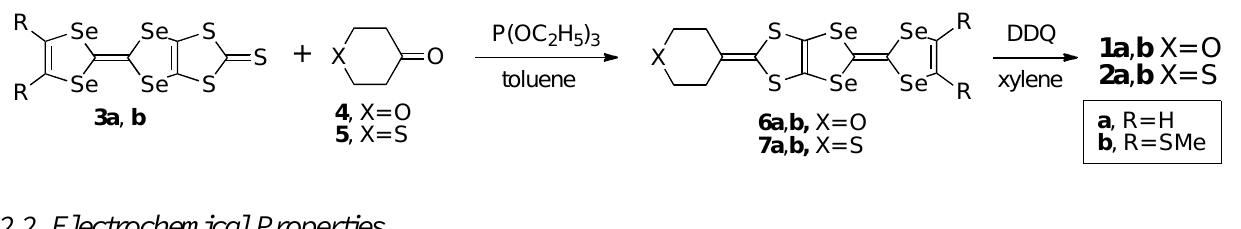
Table 1. Redox potentials of 1 and 2 (V vs. Fc/Fc + in benzonitrile containing 0.1 M Bu